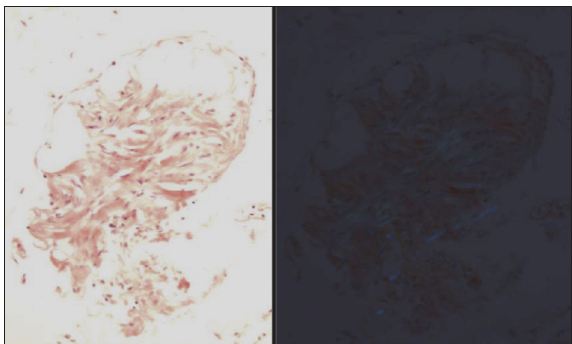
Figure 3: Abdominal fat pad biopsy showing positive Congo red staining.